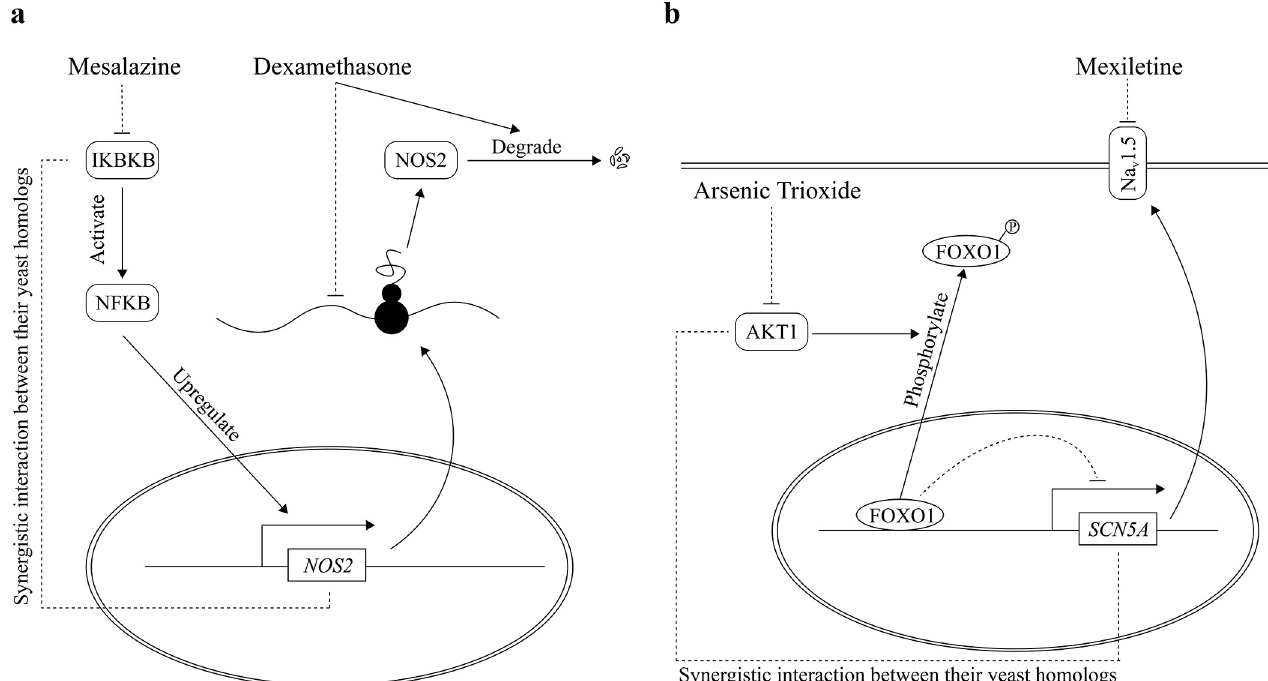
Fig 3. Genetic interaction provides possible mechanistic insights into DDIs. (a) Mesalazine inhibits IKBKB, a positive regulator of NF- κ B activity, and NF- κ B is a transcription factor which induces NOS2 transcription. Dexamethasone can inhibit the transcription of NOS2 and facilitate degradation of NOS2. The combined use of dexamethasone and mesalazine could potentially reduce the amount of NOS2 in cells to a large extent, which may affect neurotransmission, antimicrobial and antitumoral activities. (b) Mexiletine targets NAv1.5, a sodium channel encoded by SCN5A , while arsenic trioxide targets AKT1. The transcription of SCN5A is repressed by the transcriptional repressor FOXO1. AKT1 can activate the transcription of SCN5A by phosphorylating FOXO1. The combined use of mexiletine and arsenic trioxide could inactivate the transcription of SCN5A and at the same time block the existing sodium channel, which may largely reduce sodium influx in cardiac